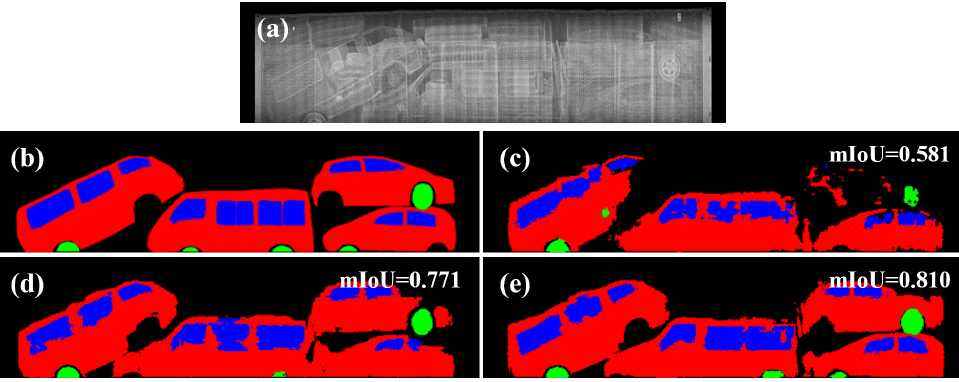
Figure 11. Segmentation results for a sample with severe occlusion: ( a ) Input BSX image. ( b ) Ground- truth semantic label. ( c ) Result obtained by using real BSX training data. ( d , e ) Augmentation results using fake images generated by pix2pix and LTH, respectively.